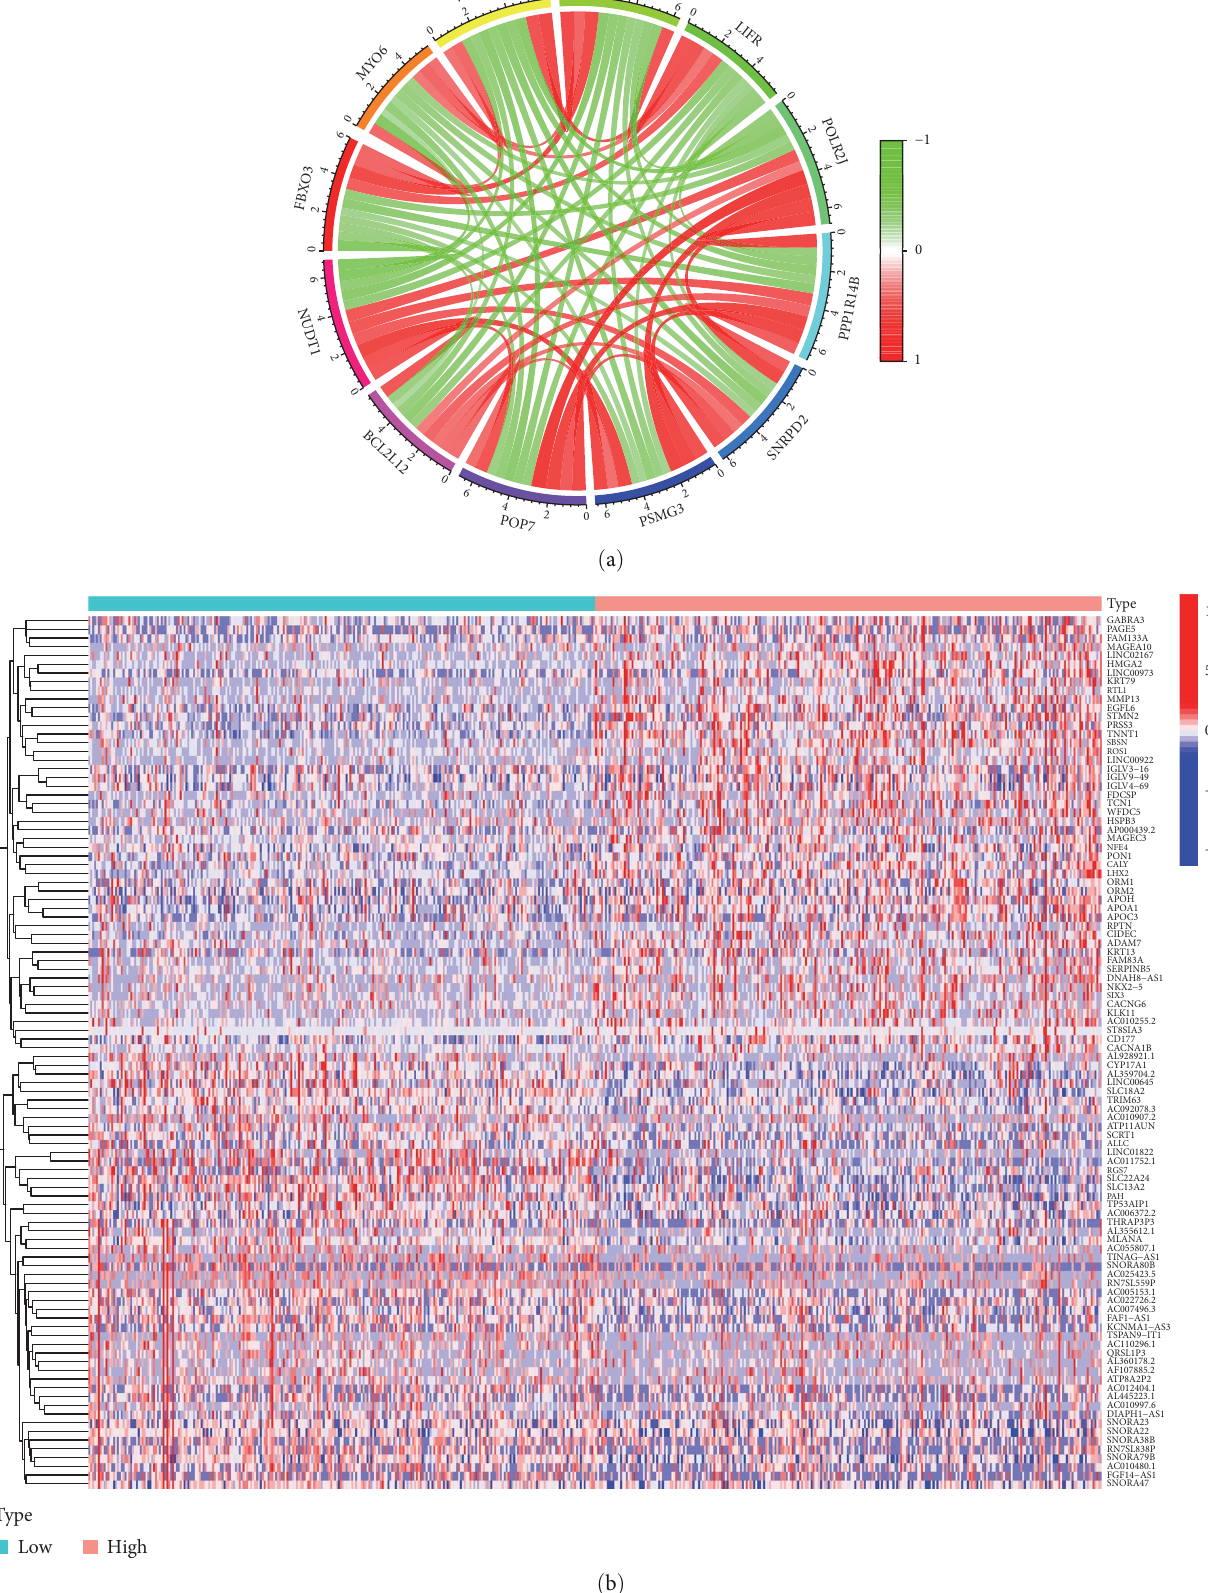
F IGURE 5: Analysis of coexpressed and differential expression of NUDT1: (a) the top 11 coexpressed genes related to NUDT1; (b) top 100 DEGs for